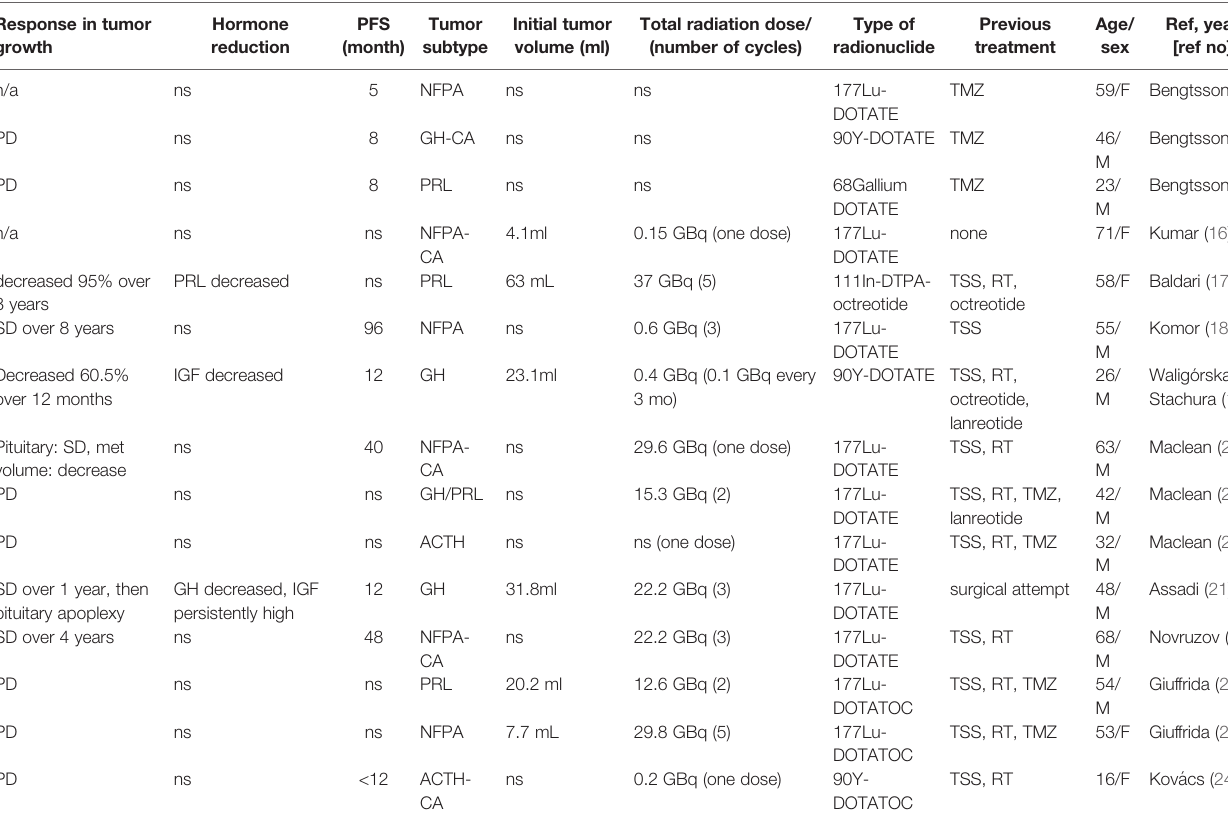
TABLE 3 | Published cases of peptide receptor radionuclide therapy (PRRT) for pituitary tumors and carcinomas. Response in tumor